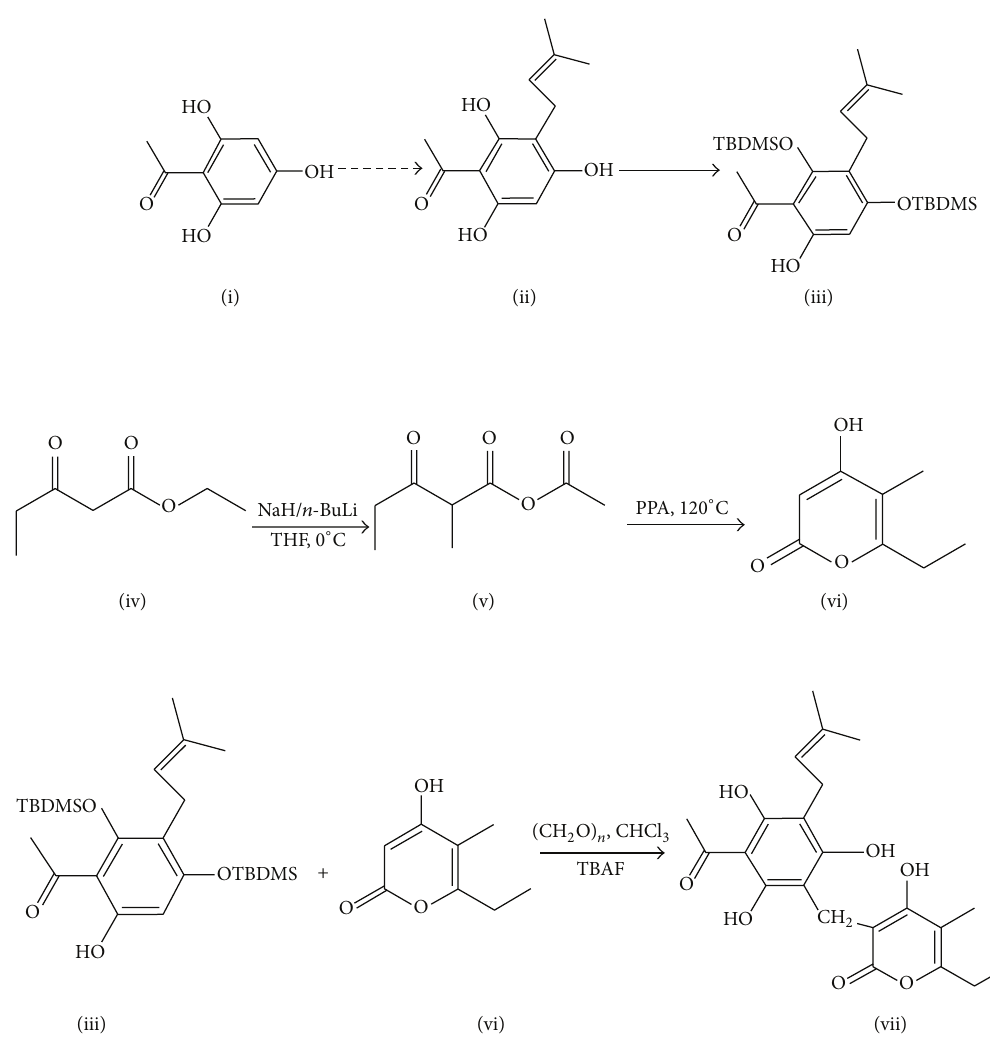
Figure 3: Synthesis of arzanol. (Adapted from Minassi et al. [20,